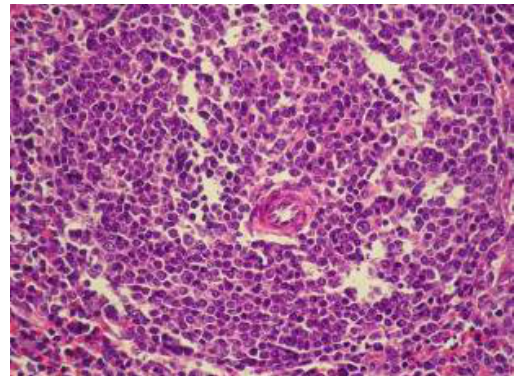
Fig. 7. Cell composition of spleen follicle, the 1 st group the 70 nd day of test. H&E. x